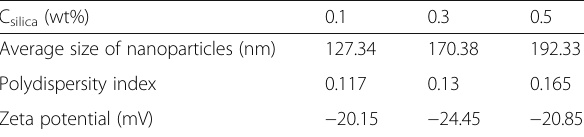
Table 1 The average size, polydispersity index (PDI), and zeta potential of solutions with different silica concentrations at 25 ° ∁